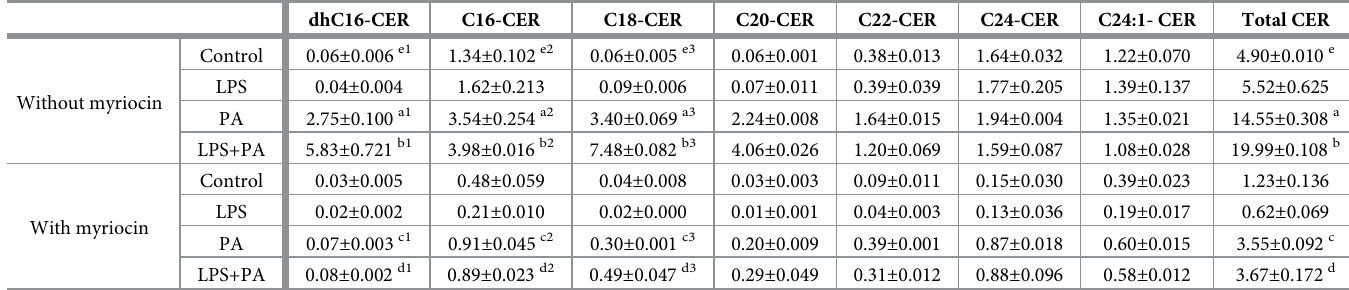
Table 4. The effect of myricin on CER synthesis stimulated by PA and LPS plus